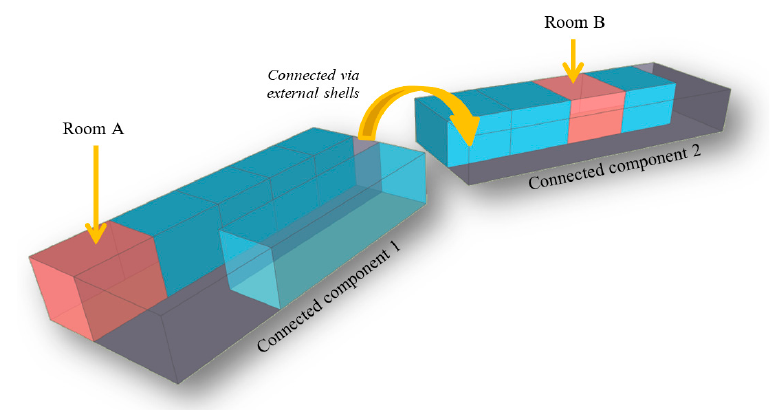
Figure 15. Traversing through multiple connected components.